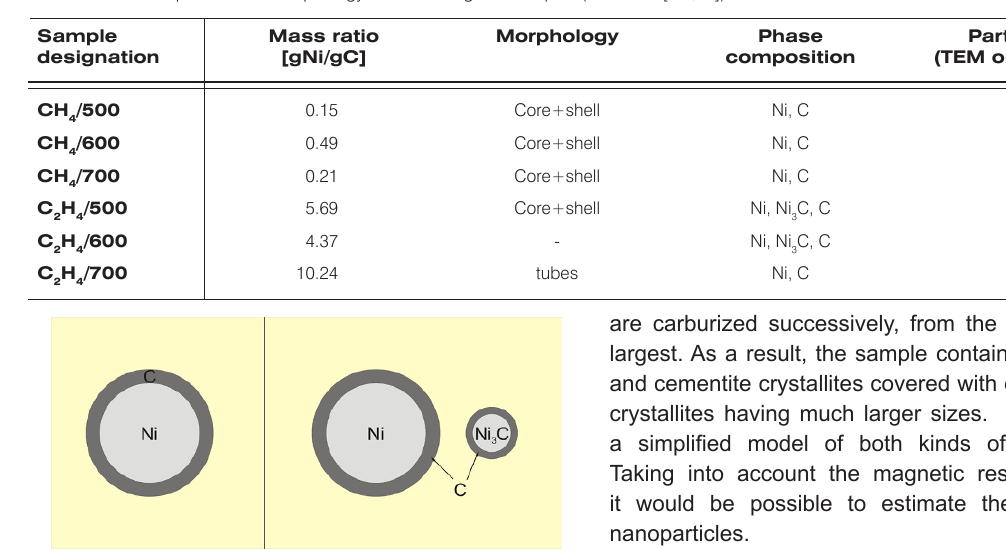
Table 2. Composition and morphology of the investigated samples (based on [